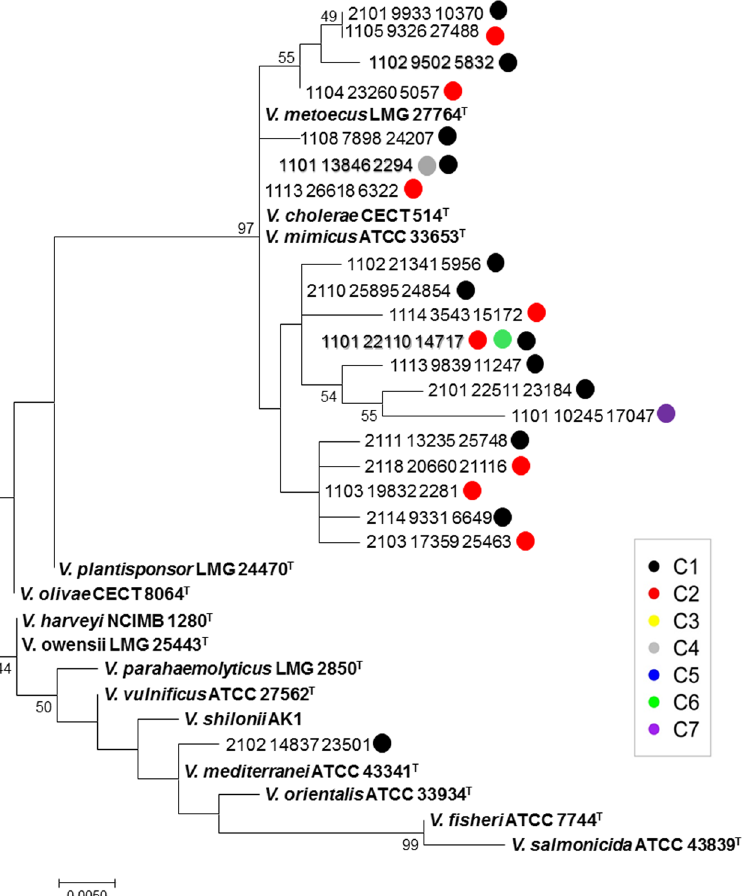
Figure 5. A maximum likelihood tree (generated in MEGA 5.0 software), based on the 16S rRNA gene sequences, showing the nearest neighbors of the most abundant Vibrio OTUs’ sequences. The different cormorant individuals (C1–C7) are marked in different colors and indicate the sequence origin from the different cormorant individuals. Bootstrap values ( > 50%) resulting from 1,000 replicates are indicated as percentages at branching nodes. Bar, 0.005 substitutions per nucleotide position. No Vibrio OTUs were detected in cormorants 3 and 5. The three most dominant OTUs (1101_22110_14717; 1102_9502_5832 and